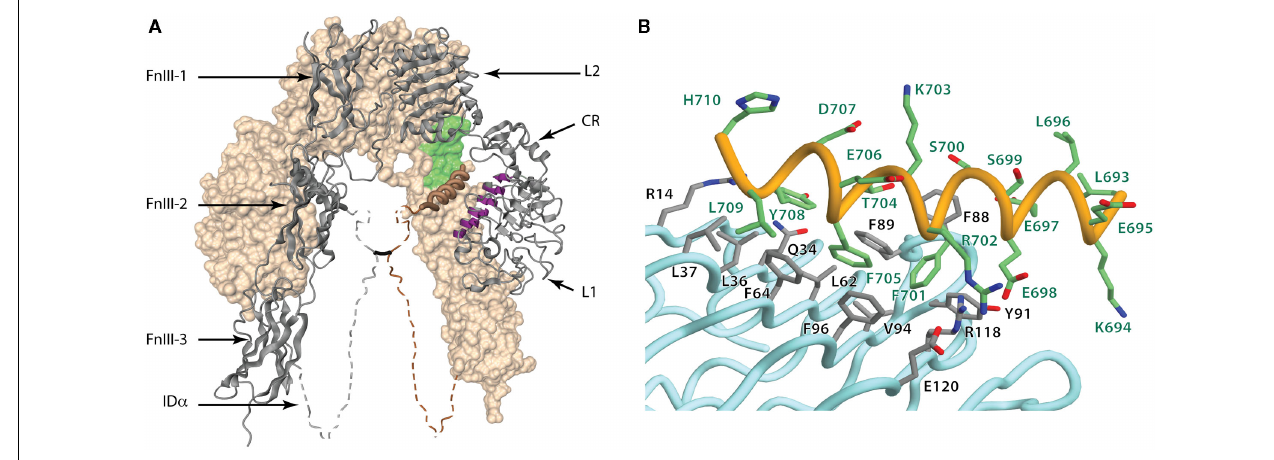
binding site within one leg of the inverted “V” are highlighted and include the surface of the central β -sheet of the L1 domain of one monomer (purple), residues at the junction of FnIII-1 and FnIII-2 domains of the adjacent monomer (light green) and the helix formed by the C-terminal segment of α -chain (brown coil). (B) Detail of the conformation of the α CT segment on the surface the central β -sheet of the L1 domain in the crystal structure of the apo -form of the insulin receptor ectodomain.The Figure is based on PDB entry 3LOH; (B) is from Smith et al. (2010), used by